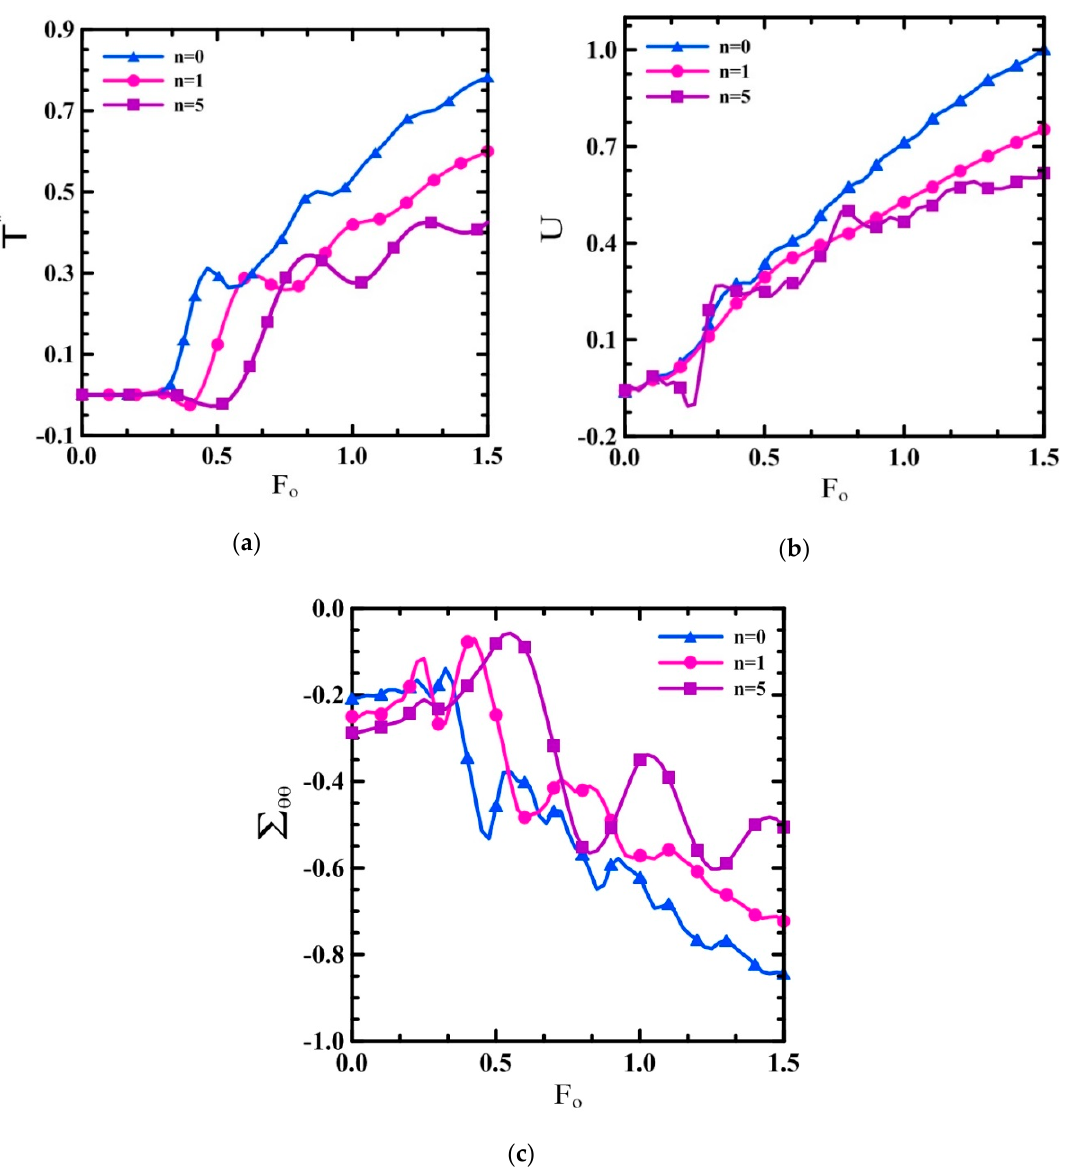
Figure 6. ( a – c ): Effect of the material gradient index n on the time histories of the thermoelastic field variables for the FG cylindrical panels with piezoelectric layers ( h c / h p = 5, θ 0 = 75 ◦ , ψ = 0.03, ξ = 0.5, θ = 0.5 θ 0 , τ = 0.2